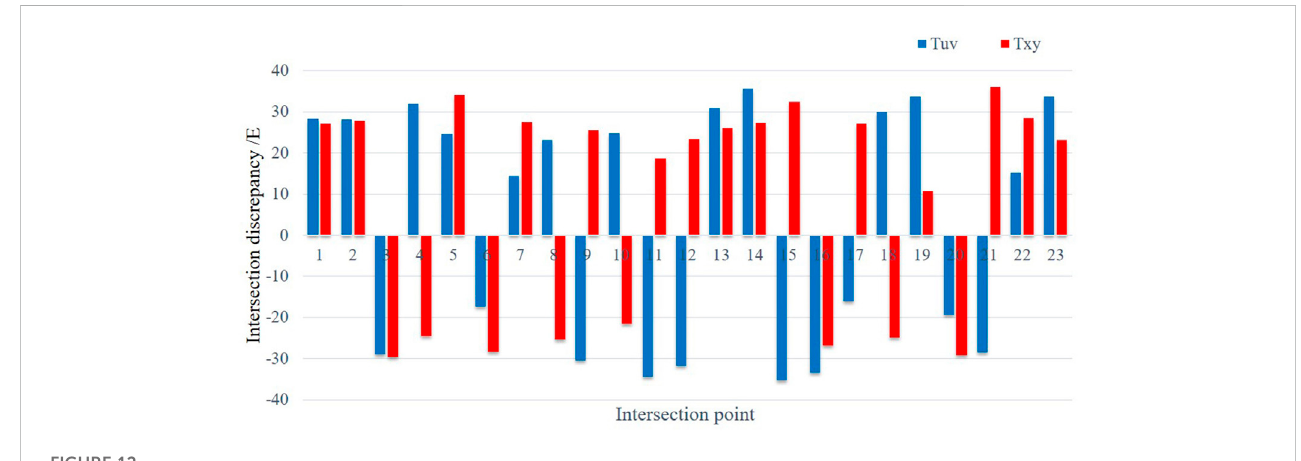
FIGURE 12 Statistics of discrepancy values at the intersection